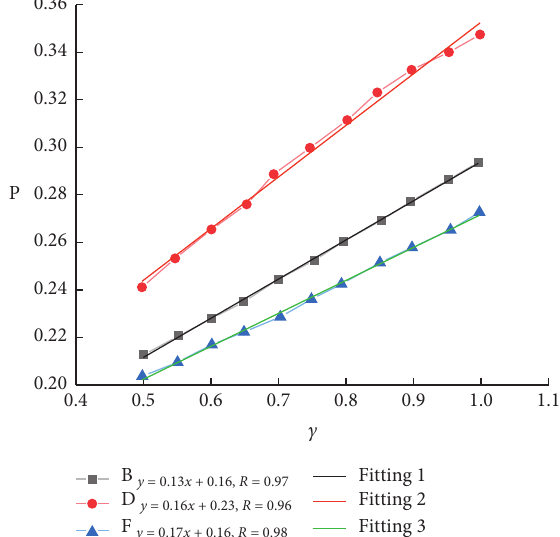
Figure 2: Relationship between correlation degree and p